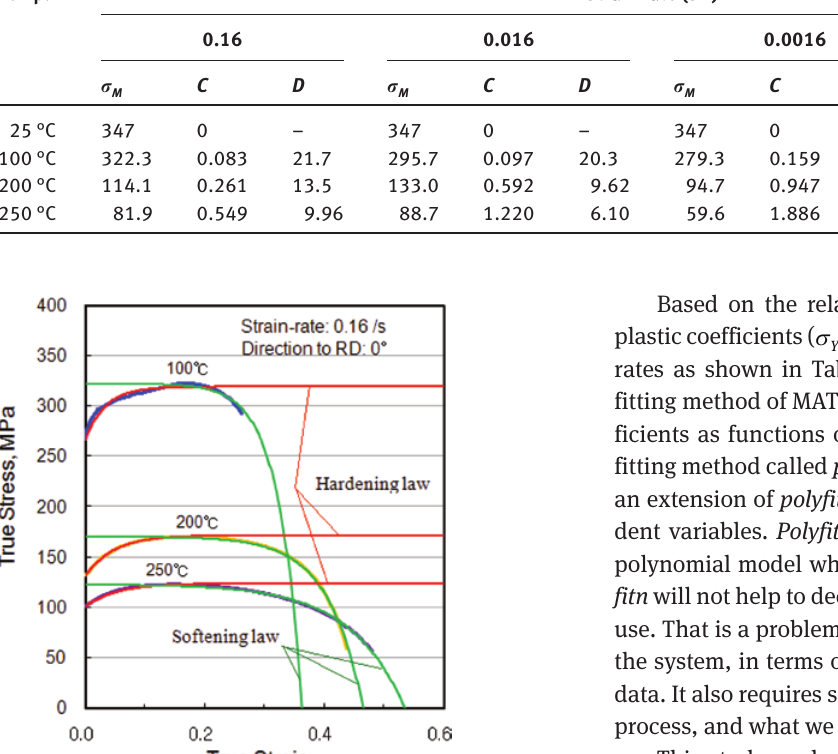
Table 3: Softening parameters at elevated temperatures and strain rates determined by fitting curves Temp.